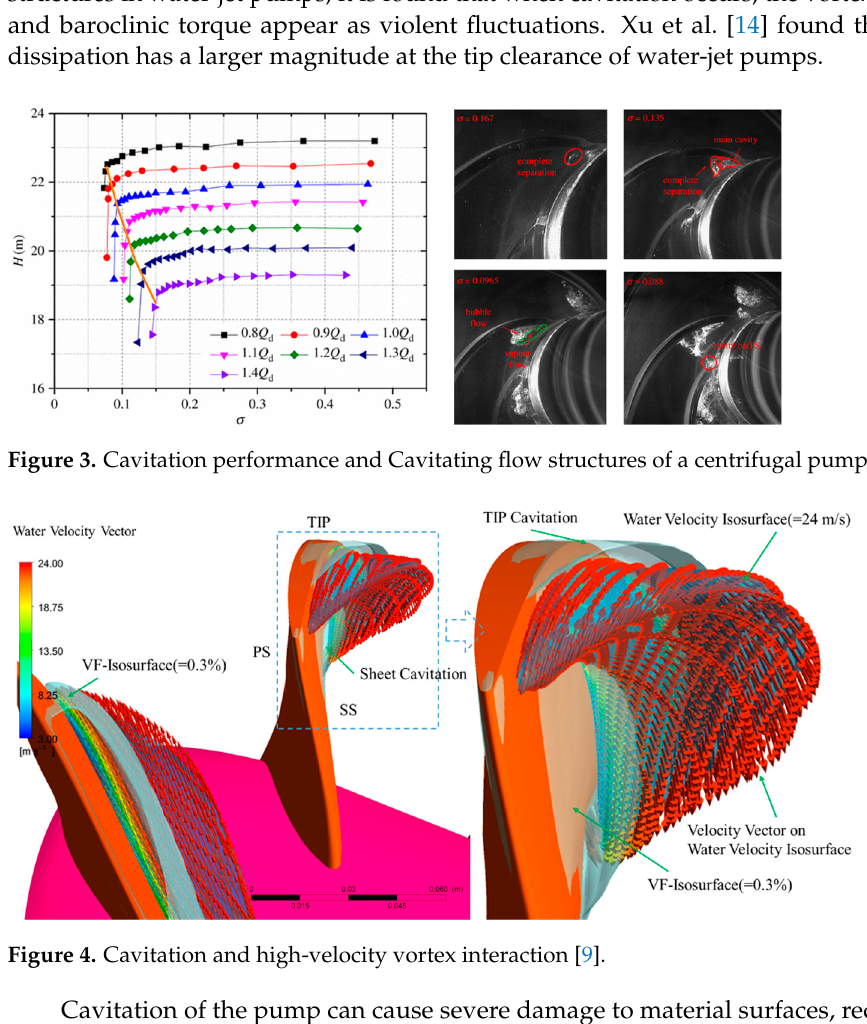
Figure 2. Cavitation distribution inside a grinder pump at different degrees of blockage [5]. ( a ) Non Clogging, ( b ) 1/4 Clogging, ( c ) 1/3 Clogging, ( d ) 1/2 Clogging.